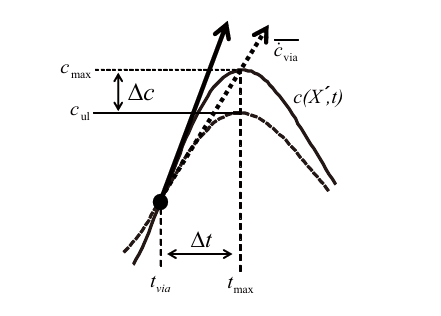
Figure 1. Conceptualsketchofcalculatingupperlimit ofvelocityatthevia-point ( ˙ c via ). ˙ c via can be calculated so that the maximum value of c ( X ′ ,t ) is equal to the upper boundary of inequality constraint ( c ul